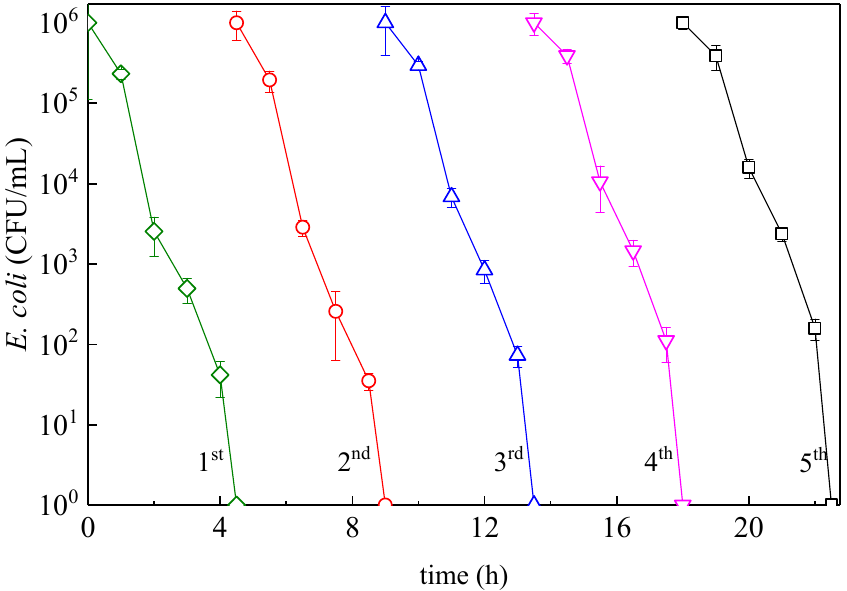
Figure 11. Reusability of flower-like Bi 2 WO 6 under low intensity solar simulated light (48 mW / cm 2 ). Solution parameters: (Catalyst) 0 = 0.2 g/L and (bacteria) 0 = 2 × 10 6 CFU/mL. Table 4. Pseudo first-order rate constants ( (cid:1863) (cid:1853)(cid:1868)(cid:1868) ) for E. coli inactivation under different conditions consistent with Figure 11.